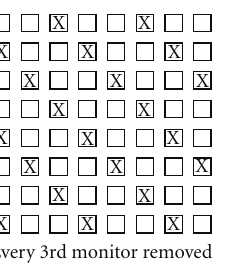
Figure 14: Two patterns of removed monitors. Removed monitors are marked with X.